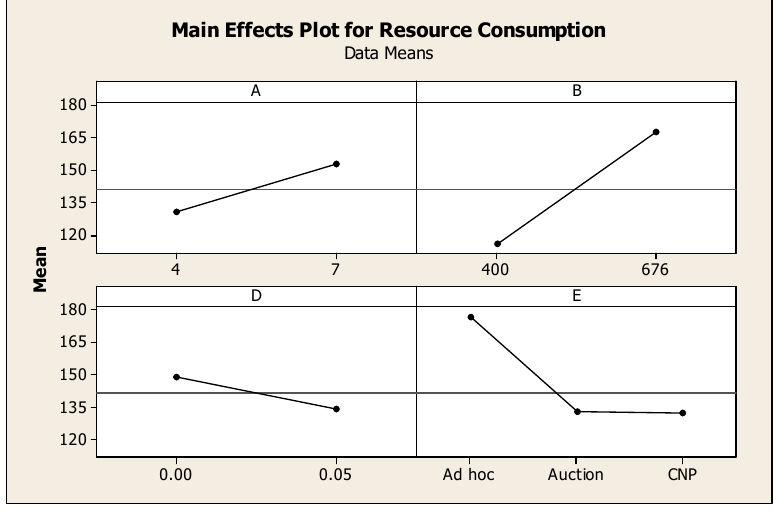
Figure 10. Main effect plot for resource consumption. n = 160, ANOVA, 1 df , p < 0.05.